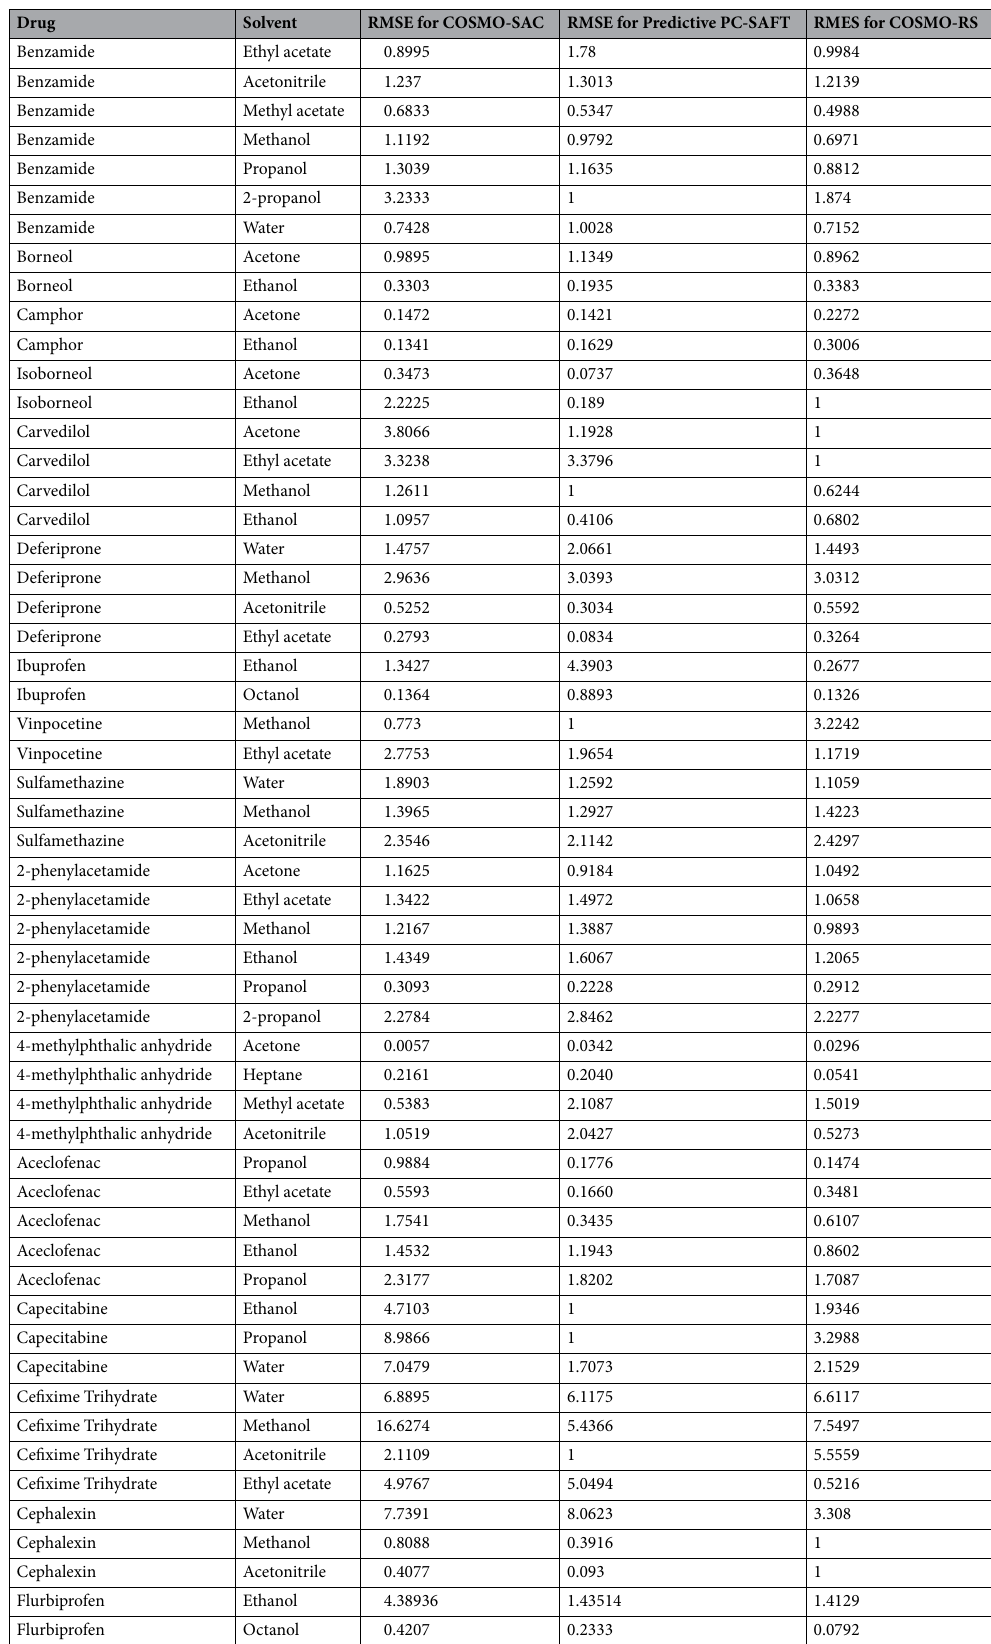
Table 3. RMSEs for predictive PC-SAFT EOS compared to RMSEs for COSMO-SAC and COSMO-RS for investigated